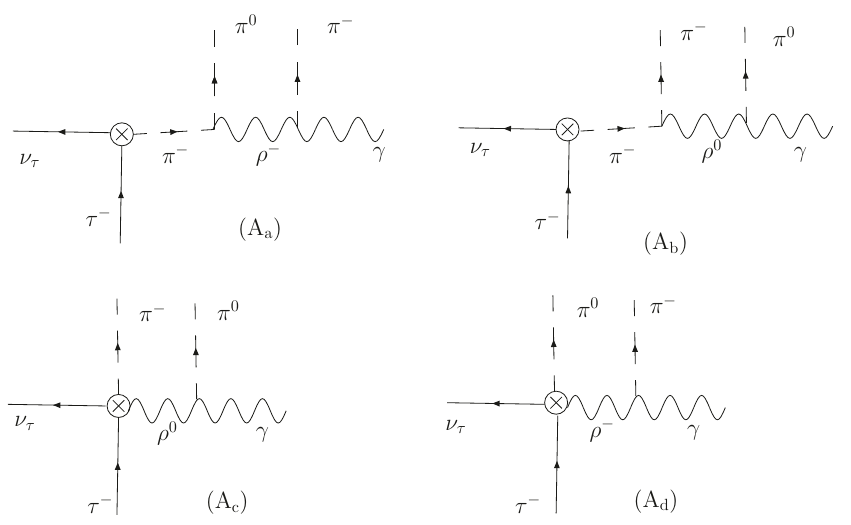
Figure 3 . Feynman diagrams contributing to the axial-vector form factors from the resonance chiral Lagrangians in eqs. (2.9) and